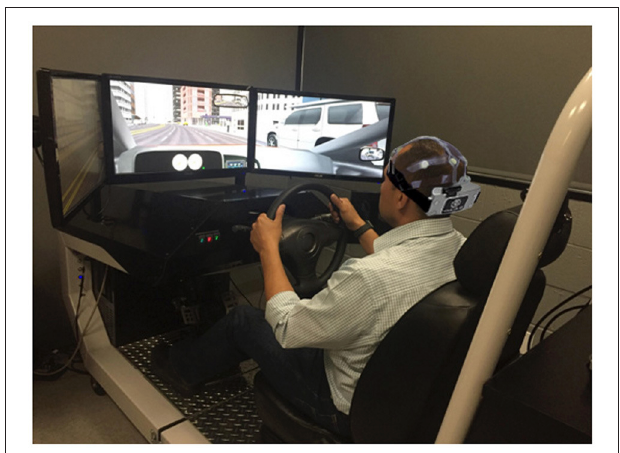
FIGURE 2 | Example of a participant identifying correct, target